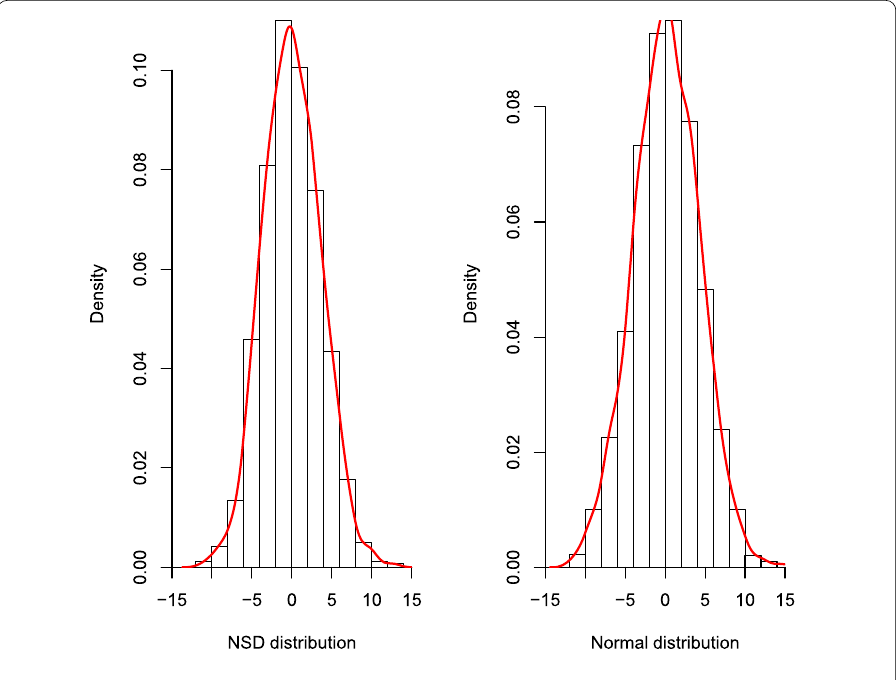
Figure 1 Histograms and fitted distributions of M-estimates residuals with different explanatory variables and M-methods (sample size is n = 1,000).